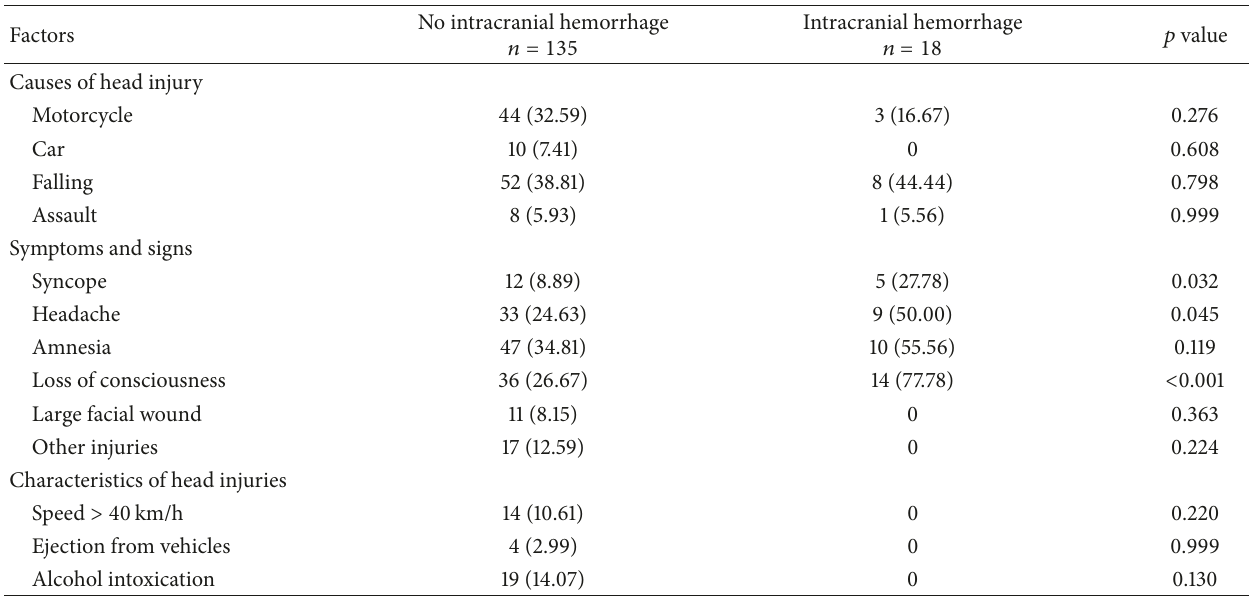
Table 2: Symptoms/signs and characteristics of head injury patients who were at moderate risk for intracranial hemorrhage categorized by evidence of intracranial hemorrhage from computed tomography of the brain.